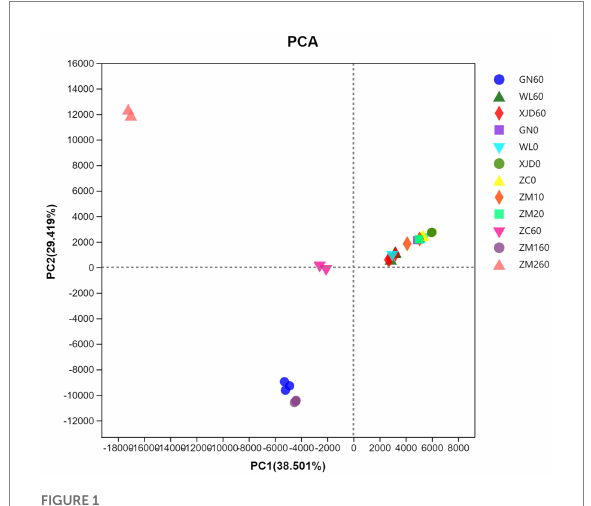
FIGURE 1 Principal component analysis (PCA) of the bacterial communities in silage and fresh materials. ZC, Zhongcao No. 3; ZM1, Zhongmu No. 1; ZM2, Zhongmu No. 2; GN, Gongnong No. 1; WL, WL168; XJD, xinjiangdaye; 0, 0 day of ensiling; 60, 60 days of